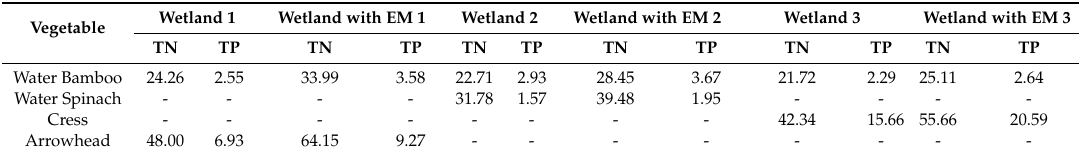
Table 8. Content of nitrogen and phosphorus in vegetables (g kg − 1